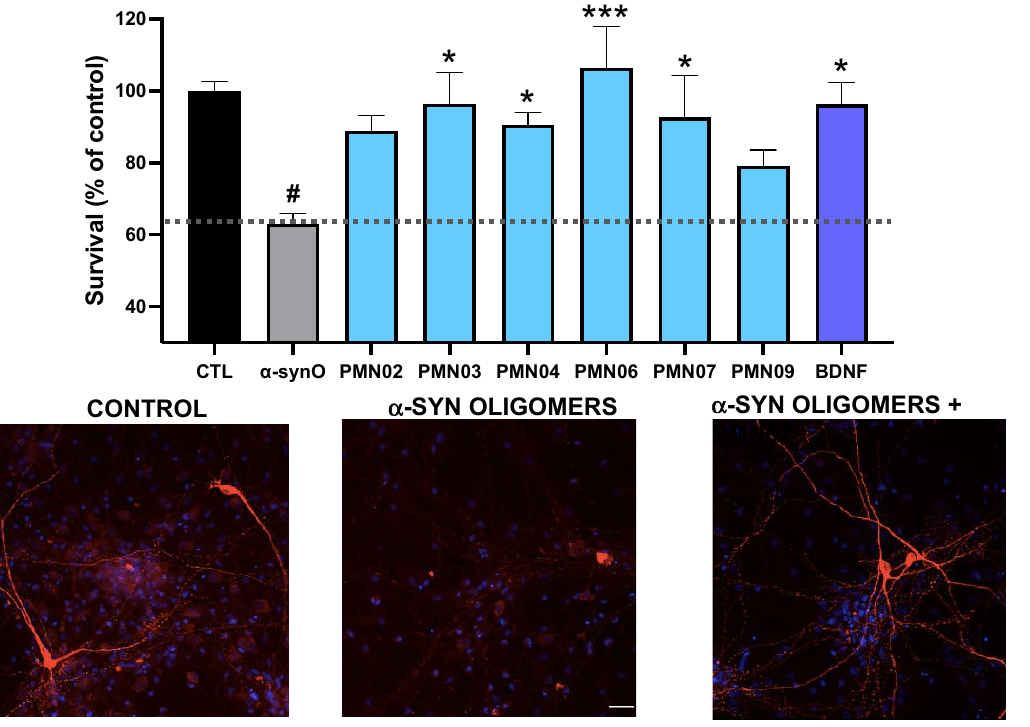
Figure 9. mAb inhibition of oligomer toxicity in dopaminergic neurons. Cultures of primary rat dopaminergic neurons were exposed to toxic α -syn oligomers ( α -synO; 0.5 µM) without or with mAbs (0.25 µM). Survival is expressed as the percentage of viable neurons compared to a control culture with vehicle only (CTL). BDNF was used as a positive control. Results shown are the mean + SEM of 6 replicate cultures. A global analysis of the data was performed using one-way ANOVA followed by Dunnett’s multiple comparisons test. # p < 0.005 vs. CTL, * p ≤ 0.05 vs. α -synO, *** p ≤ 0.001 vs . α -synO. No statistically significant difference between BDNF and CTL or mAbs and CTL. Representative images of cultures with staining for neurons (MAP2, red ) and nuclei ( blue ) are shown.